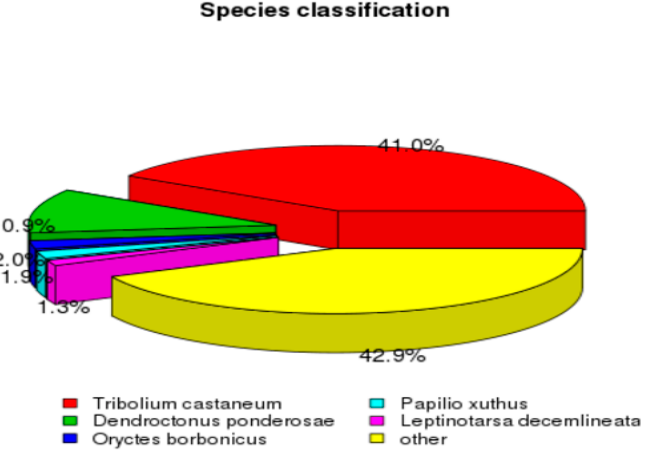
Figure 2. The unigene BLASTx searches against the Nr database for species distribution analysis.